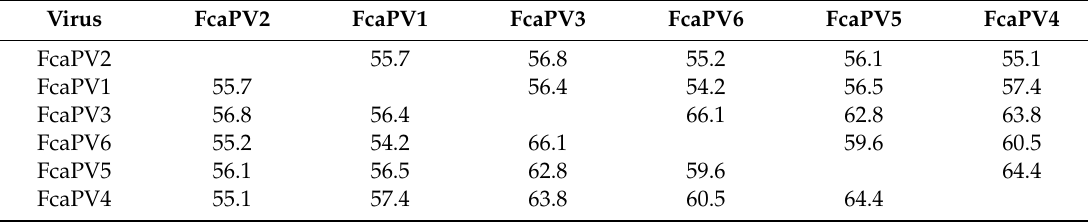
Figure 2. Felis catus Papillomavirus 6 (FcaPV6) genome configuration using metadata. The predicted ORFs are represented by the coloured inner segments. GC content is displayed in blue, percentage nucleotide polymorphism in orange and read coverage in yellow. Table 1. Percentage pairwise nucleotide sequence identities of feline papillomaviruses in the L1